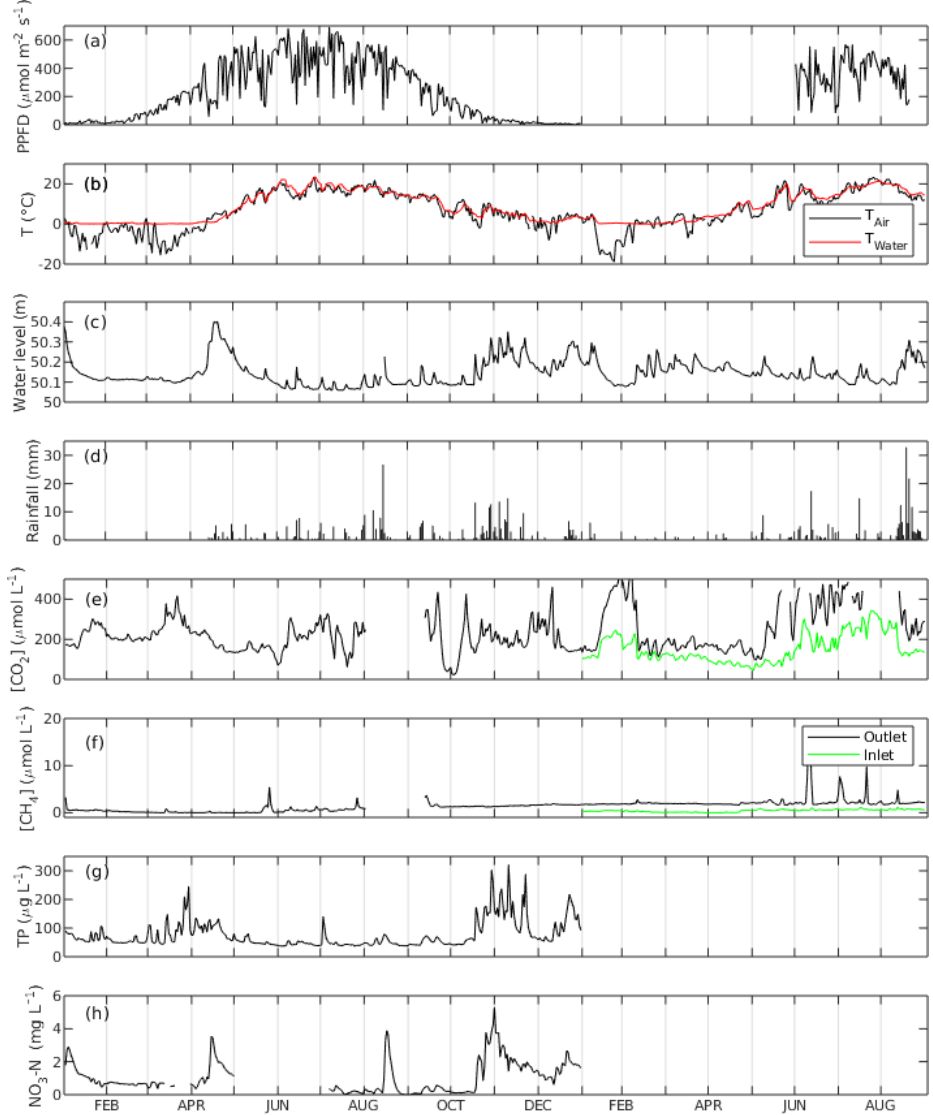
Figure 2. The daily average of (a) photosynthetic photon flux density (PPFD), (b) air and water temperature ( T air and T water ), (c) water level, (d) rainfall, (e) CO 2 concentration ([CO 2 ]), (f) CH 4 concentration ([CH 4 ]), (g) concentration of total phosphorus (TP) and (h) concentration of NO 3 -N of the Nummela wetland from January 2013 to August